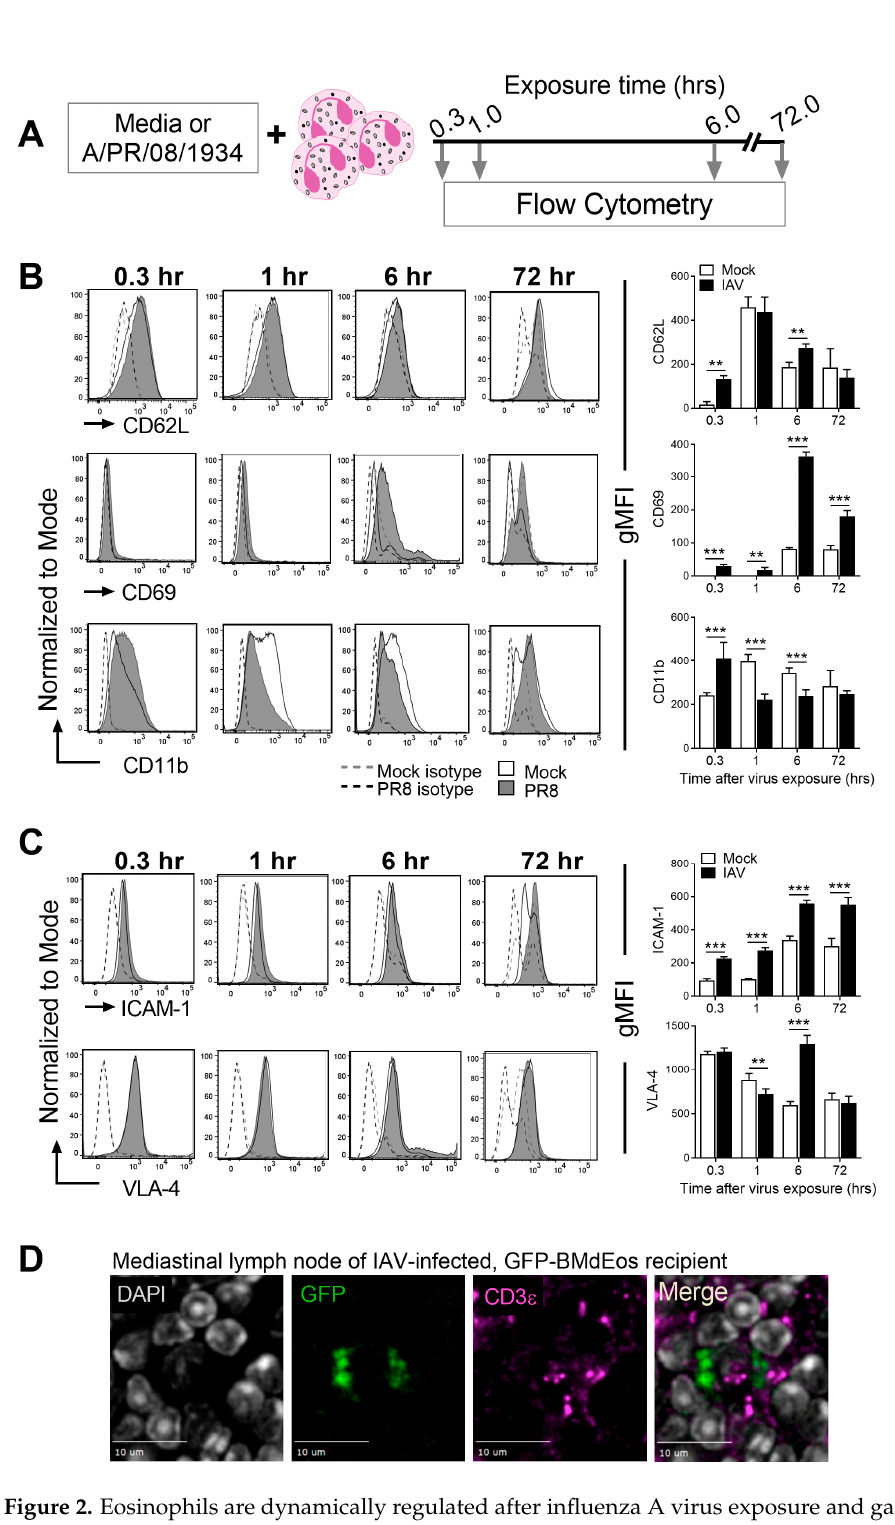
Figure 2. Eosinophils are dynamically regulated after influenza A virus exposure and gain migratory properties. ( A ) Schematic representation of experimental setup. Representative histograms of SSC hi SiglecF + CCR3 + eosinophils from mock (open) and virus exposed (grey) cells and isotype controls (dotted line) and quantification of geometric mean fluorescence intensity (gMFI) for ( B ) activation and ( C ) adhesion markers. ( D ) Green fluorescent protein (GFP)-tagged eosinophils localize to the T cell zones of mediastinal lymph nodes after adoptive transfer into the lungs of virus-infected mice. Experiments were independently repeated three times for reproducibility. Data in graphs are represented as the mean and standard deviation of n = 5 samples analyzed by two-way ANOVA with Tukey’s multiple comparisons test of one independent study. ** p < 0.01 and *** p <